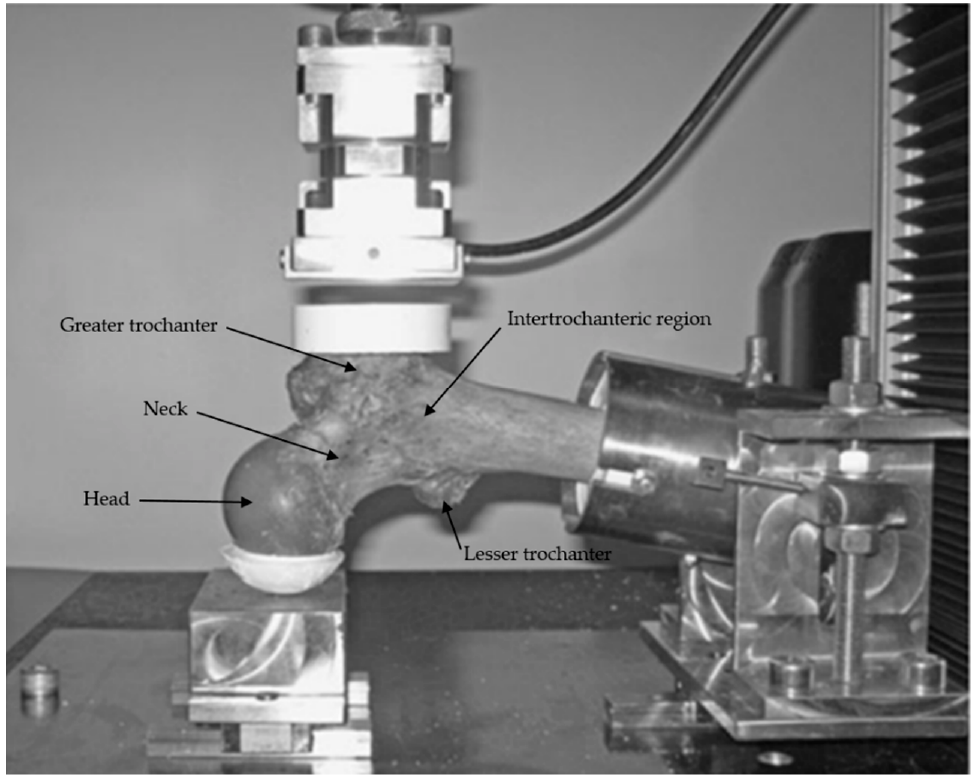
Figure 1. Loading apparatus for mechanical testing of the proximal femur. The orientation of the femur in the loading apparatus was designed to simulate a sideways fall on the greater